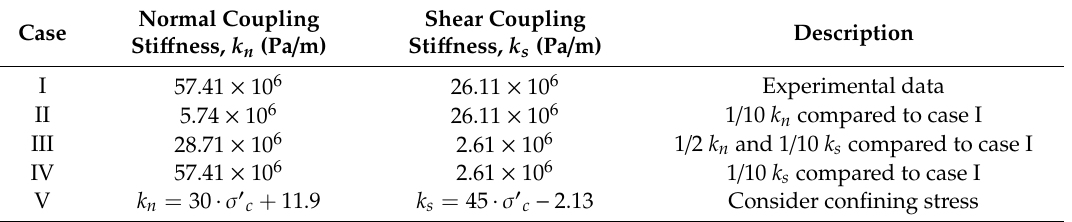
Table 3. Comparison of cases for parametric